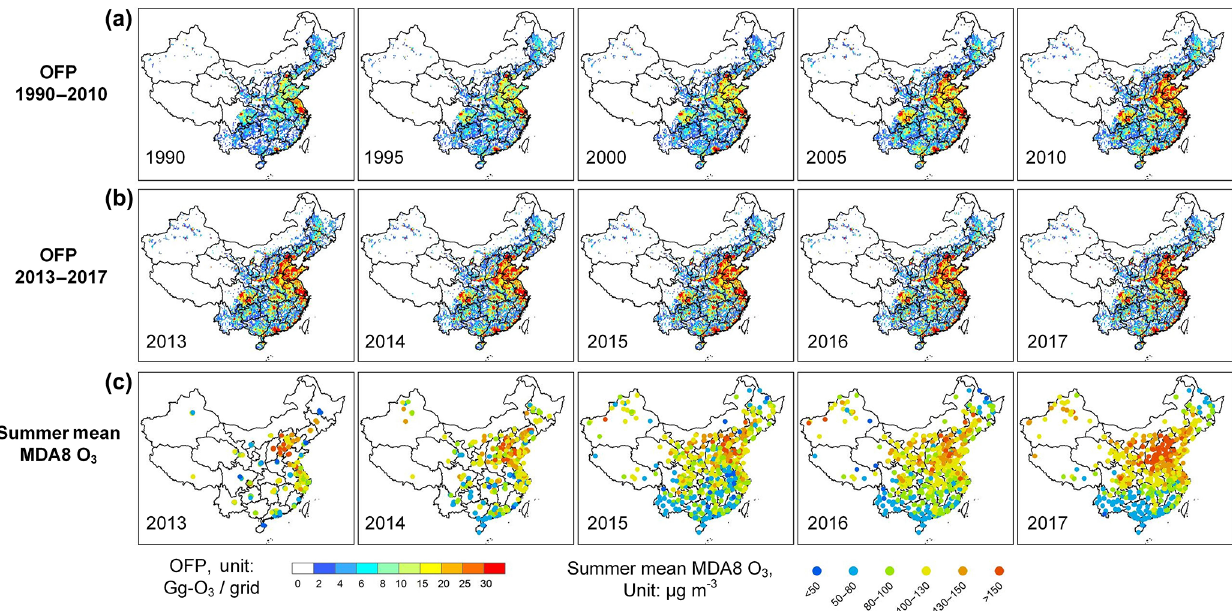
Figure 6. OFP spatial distributions during 1990–2017 (a, b) , and the observed summer mean (June–July–August) maximum daily 8h average (MDA8) surface ozone concentrations in 2013–2017 (c)